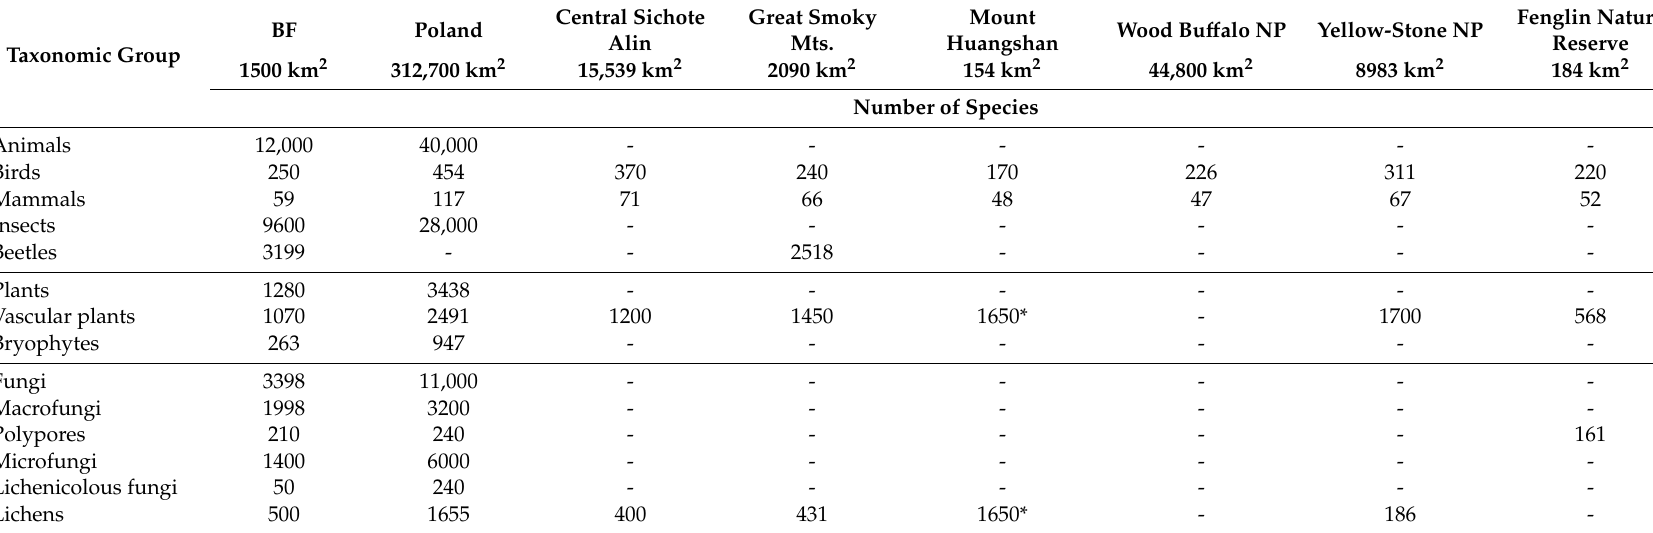
Table 1. Species richness of some taxonomic groups of organisms of Białowie˙za Forest (1500 km 2 ) on the background of species richness of Poland (312,700 km 2 ) and the United Nations Educational, Scientific and Cultural Organization (UNESCO) forest world heritage sites from Palearctic and Nearctic, for which published data